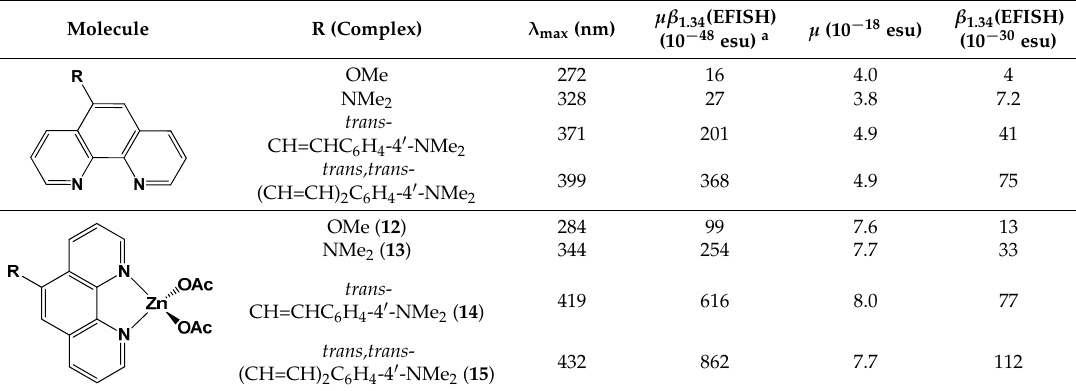
Table 2. Electronic spectra, dipole moments, and β 1.34 (EFISH) of Zn(II) phenanthroline complexes in CHCl 3 solution [38].